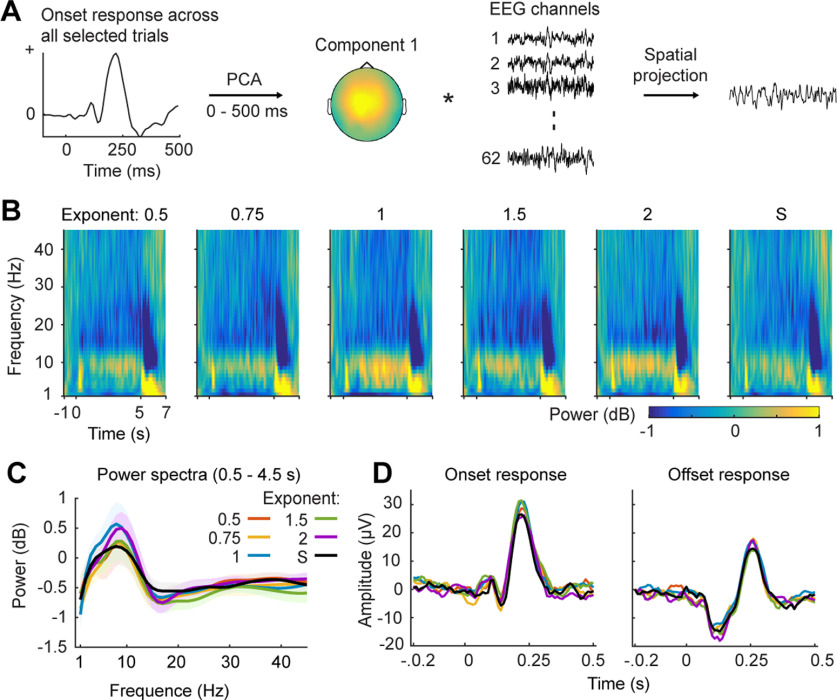
Spatial projection of EEG signals, induced power, and onset/offset responses. A, PCA component extraction and EEG spatial projection. To extract auditory responses across different EEG electrodes, we averaged EEG signals across all the selected trials and calculated the onset response to the stimulus onset (left panel). Five PCA components were extracted across all EEG channels and the first PCA component, which explained the largest variance, was selected. The middle panel shows an example topography of weights of the first PCA component from one participant. We then projected EEG signals of each trial across electrodes to the first PCA component using its weighting matrix and derived signals that summarized auditory-related responses across EEG electrodes. B, Spectrograms of induced power for each type of AM stimuli. From left to right, each spectrogram represents induced power of each AM type. C, Induced power spectra. We averaged induced power from 0.5 to 4.5 s after stimulus onset for each type of AM stimuli to avoid influences of onset and offset responses and motor components caused by button presses. The line color codes for different AM spectra as in Figure 1. The shaded area represents ±1 SE over participants. No significant differences were found between different AM types (p > 0.05). D, Onset and offset responses to each type of AM stimuli. The line color codes for different AM type. No significant differences were found between different AM types (p > 0.05).